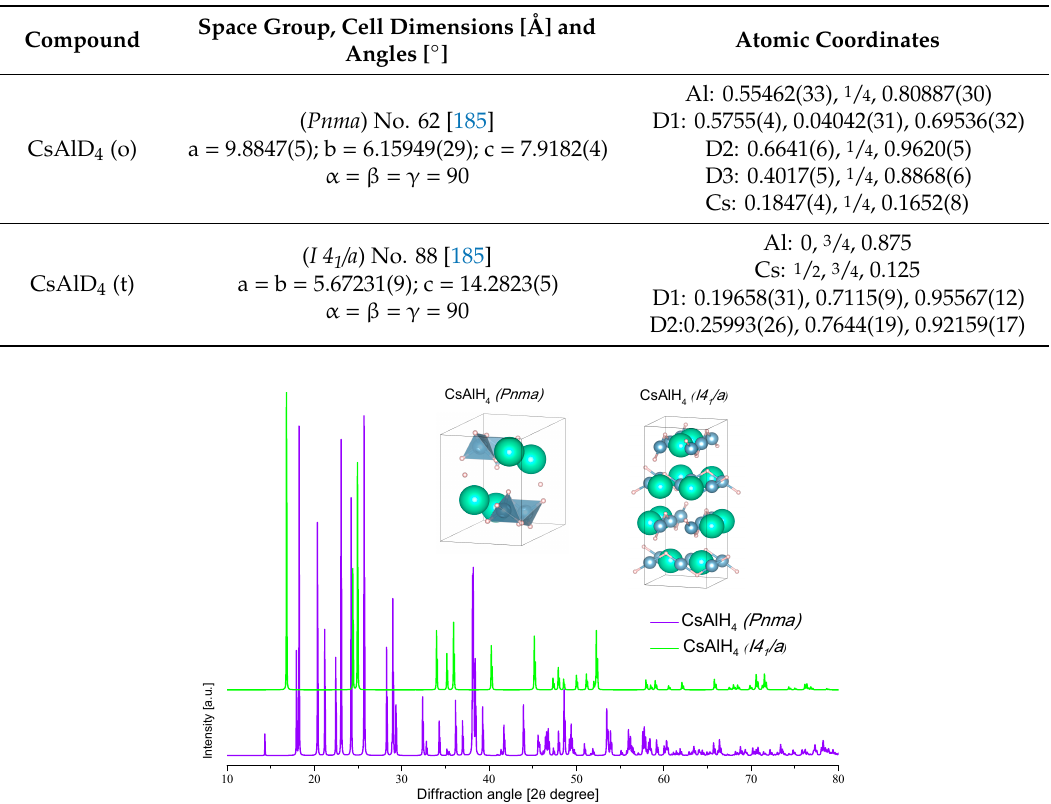
ff raction patterns ( λ = Cu k α 1